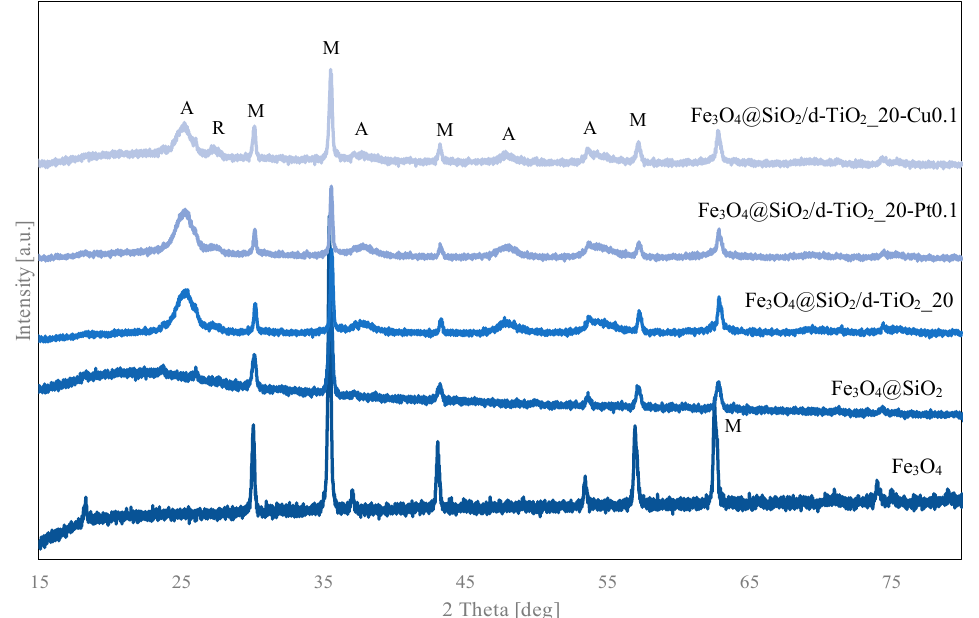
Figure 3. XRD patterns of magnetic photocatalysts, compared with Fe 3 O 4 and Fe 3 O 4 @SiO 2 (A—anatase, R—rutile, and M—magnetite).